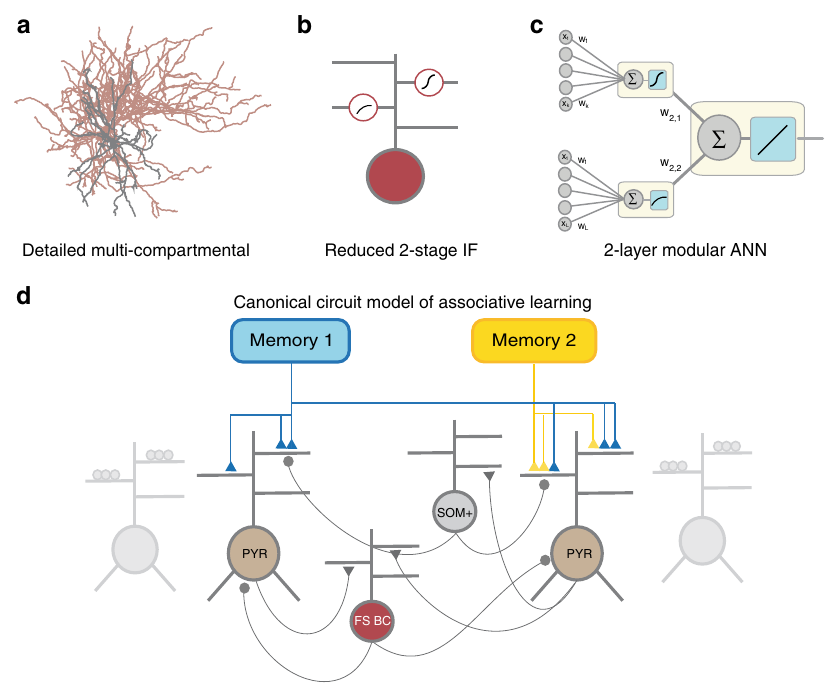
Fig. 1 Modeling tools used to study dendritic integration in FS BCs and its functional implications. a Detailed, biophysically constrained multi- compartmental models using realistic anatomical reconstructions. b Reduced two-stage integrate and fi re models of FS BCs. c two-layer ANN reduction describing the FS BCs. d Reduced network model with simpli fi ed pyramidal, FS BCs and SOM + interneurons. FS BCs and SOM + interneurons provide feedback inhibition to excitatory neurons, with FS BCs targeting the somatic subunit while SOM + neurons target the dendritic subunits. Memory encoding afferents provide inputs to excitatory cell